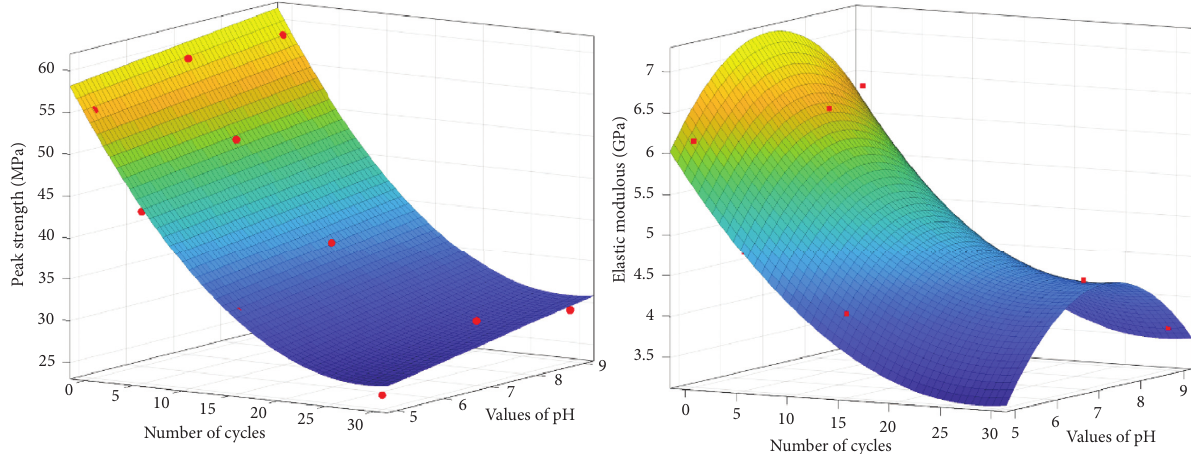
Figure 5: Parameter plane